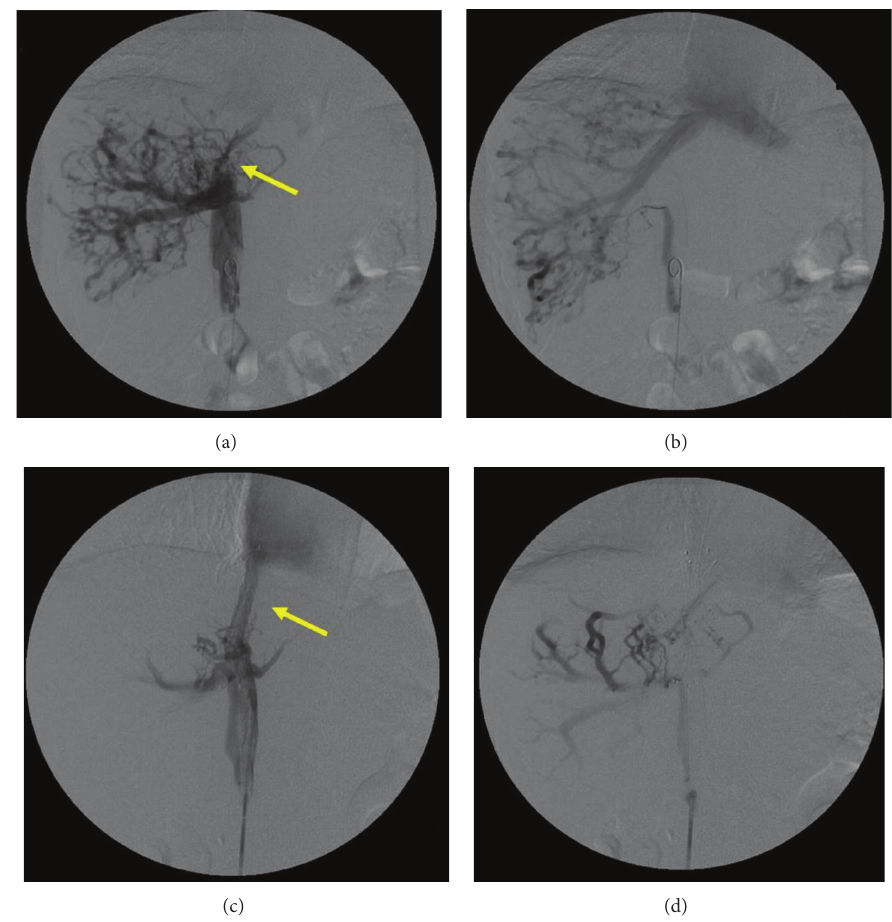
Figure 2: Angiography. ((a), (b)) Angiography reveals a thrombus in the inferior vena cava, which extends from its outlet to the right atrium. The intrahepatic collaterals are also shown. A portion of thrombus is indicated by the arrow. ((c), (d)) We performed PTA with stent implantation (LUMINEXX 14 × 80 mm) and successful balloon dilatation (OPTA Pro 10 × 40 mm) of the inferior vena cava at its outlet to the right atrium. The arrow points to the the